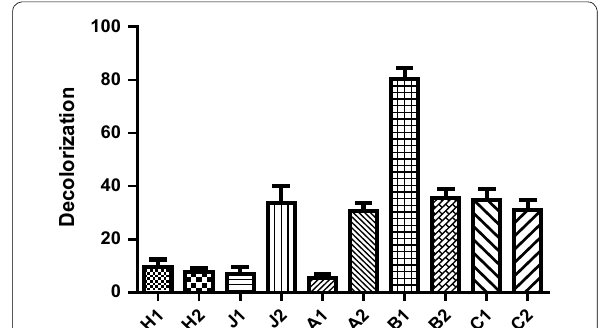
Fig. 1 Decolorization of Remazol black B by different isolates at concentration 50 mg L − 1 after 24 h incubation in MSM media supple- mented with 0.1% glucose and 0.4% yeast extract, at pH 7 and 30 °C under static conditions